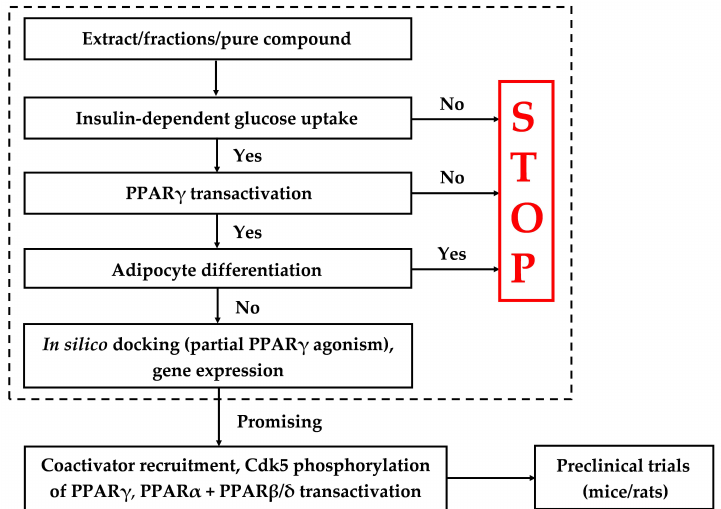
Figure 1. Screening platform for the identification of partial PPAR γ agonists with potential antidiabetic properties. The most essential part of the screening platform is indicated in the dotted